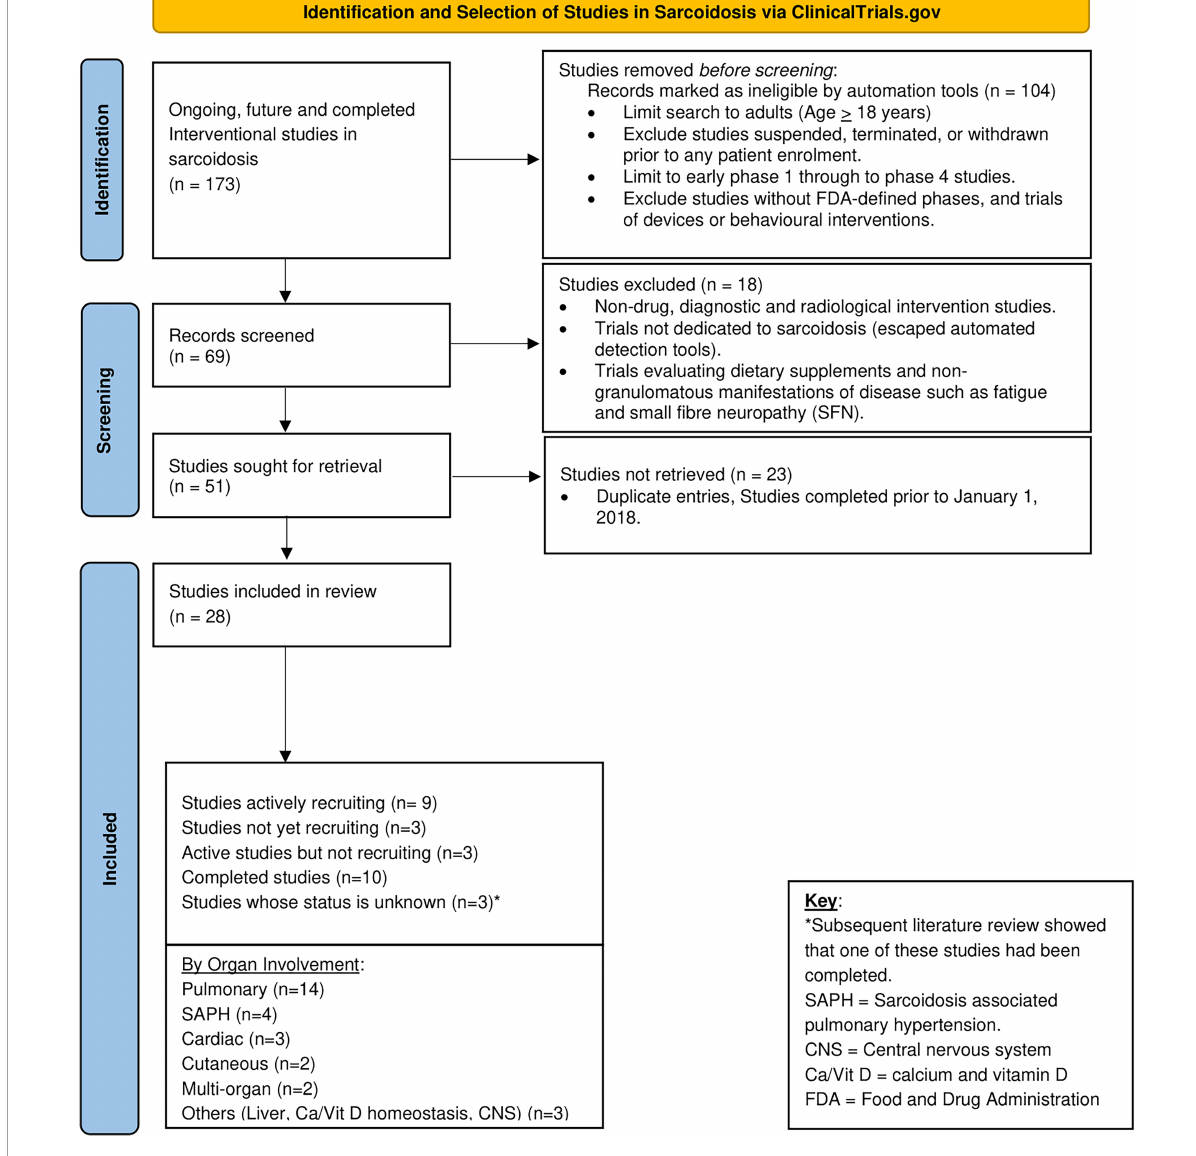
FIGURE4 Active, future, and recently concluded clinical trials in sarcoidosis in the past 5-years